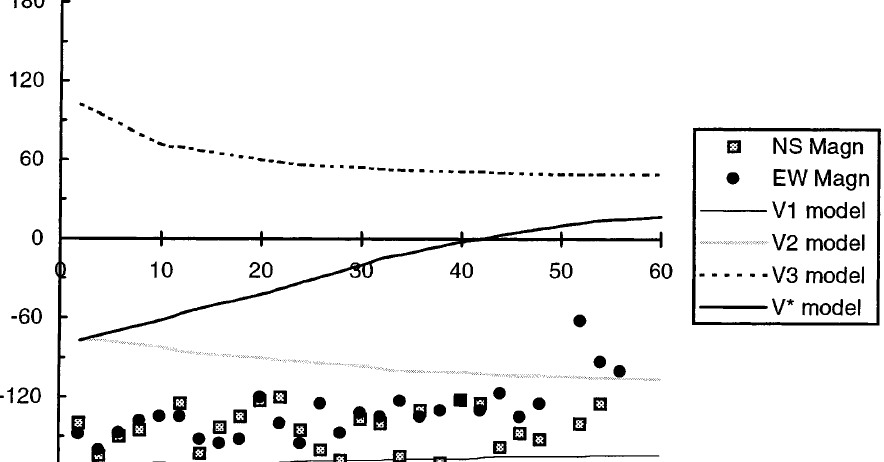
Fig. 12a, b. Variation of a Doppler velocity and b phase with pulsation frequency. Ob- servations are compared with Sutcli(cid:128)e and Poole (1990) model predictions; symbols as in